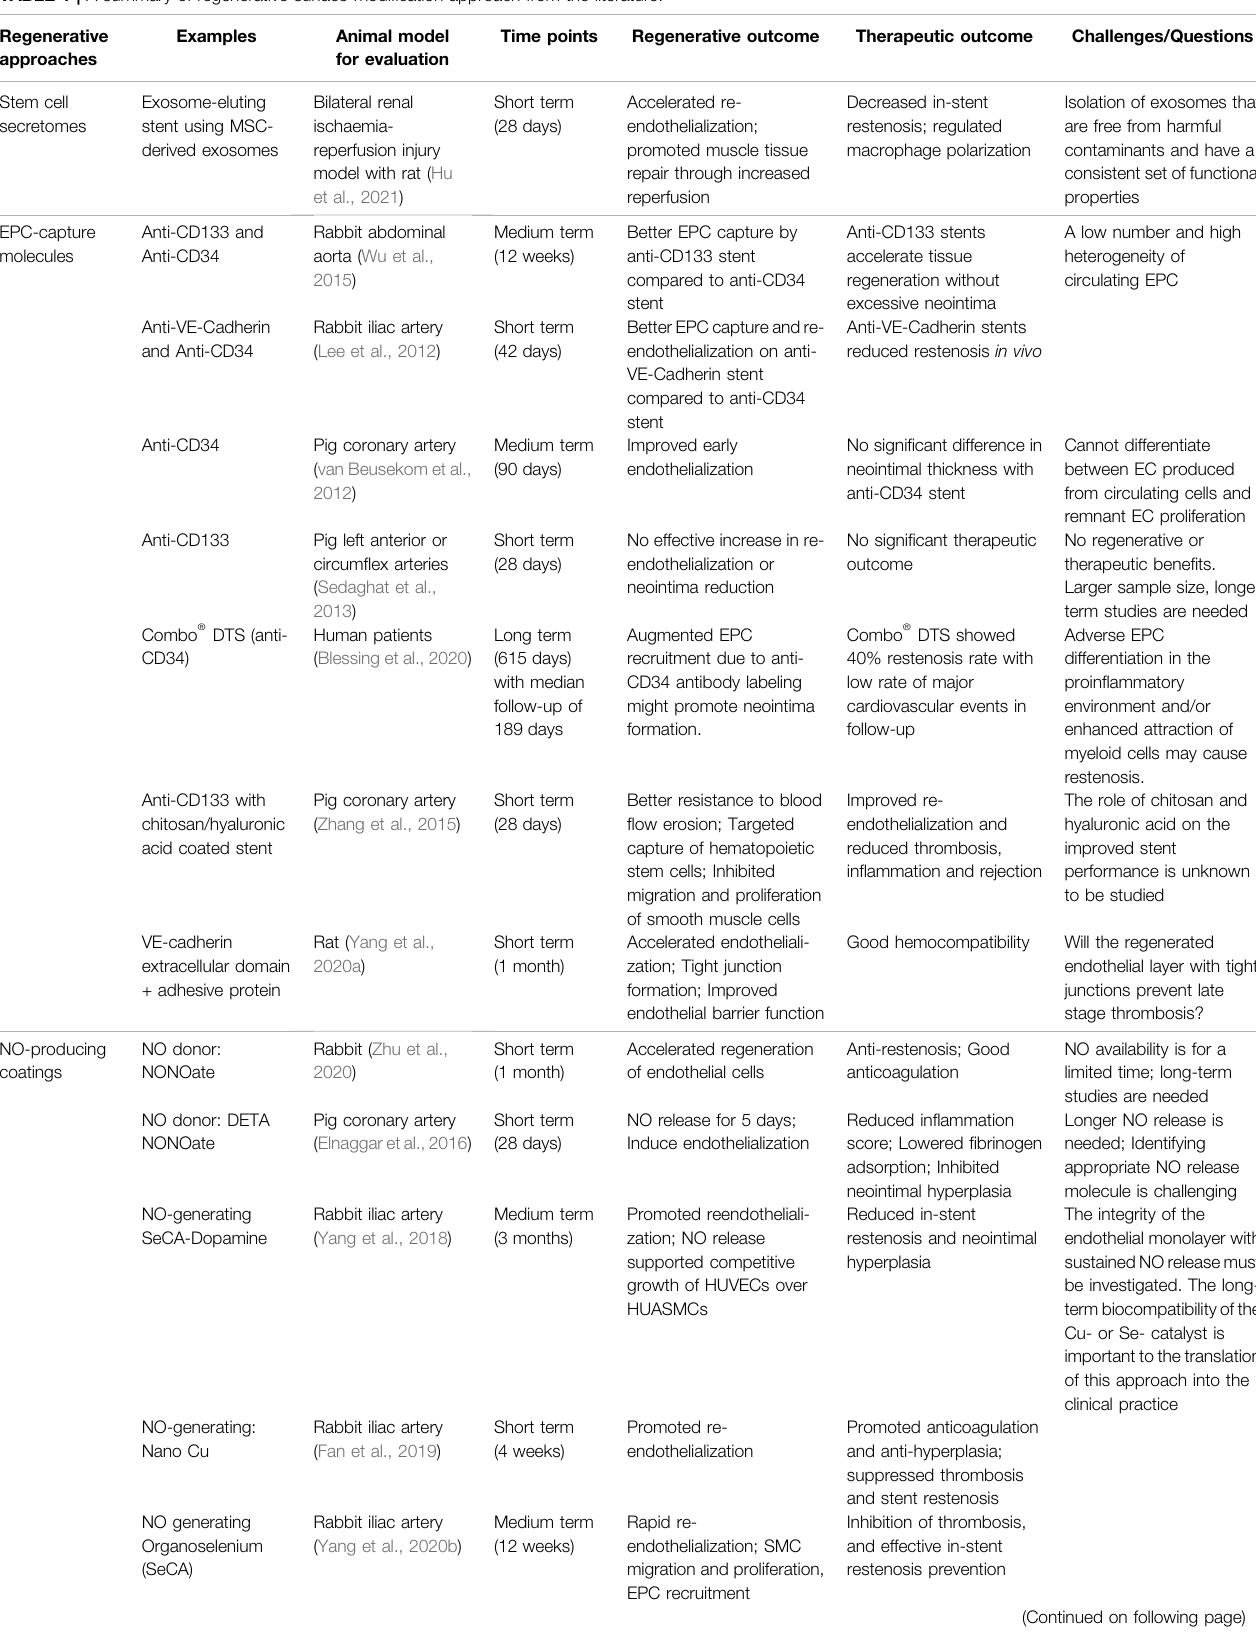
TABLE 1 | A summary of regenerative surface modi fi cation approach from the